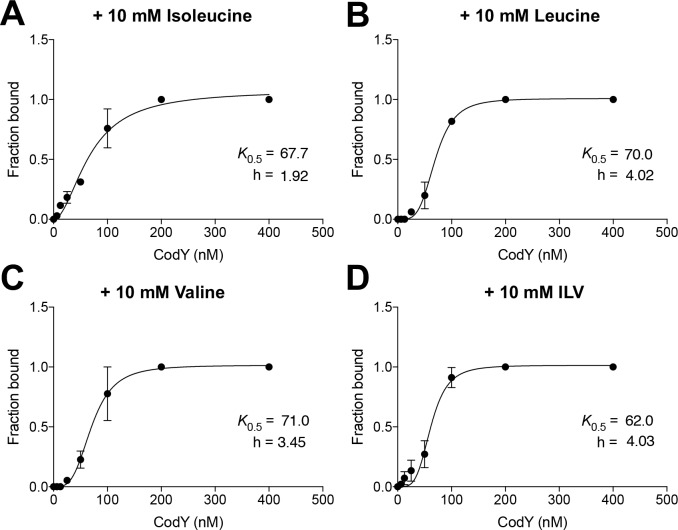
CodY binds all three branched-chain amino acids in vitro.Fraction of bound ilvD266p+ fragment was analyzed in EMSAs containing GTP and A) isoleucine, B) leucine, C) valine, or D) all three amino acids (ILV). The binding constants (K0.5) and Hill coefficients (h) were determined by fitting the data to the Hill equation [98]. Data points indicate the mean +/- SEM of two independent experiments. Error bars were plotted for all points; in some cases, the error bars are too small to see.